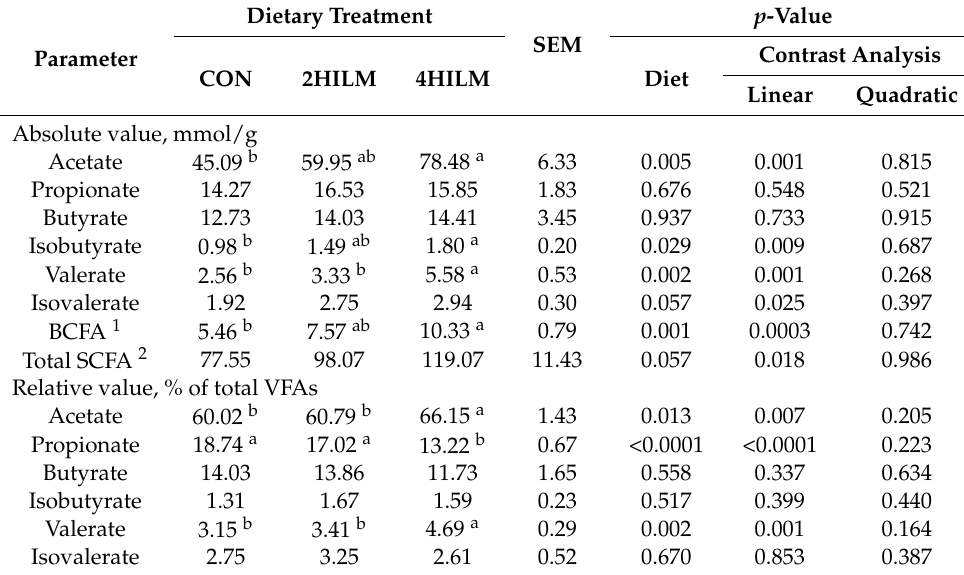
Table 4. Effect of the dietary Hermetia illucens larvae meal (HILM) inclusion level on the volatile fatty acid (VFA) concentrations in the cecal contents of laying hens.